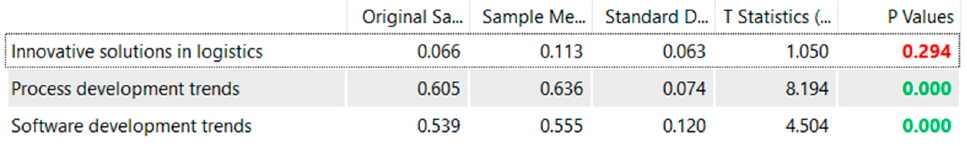
Figure 3. Quality criteria: R2 of the model.